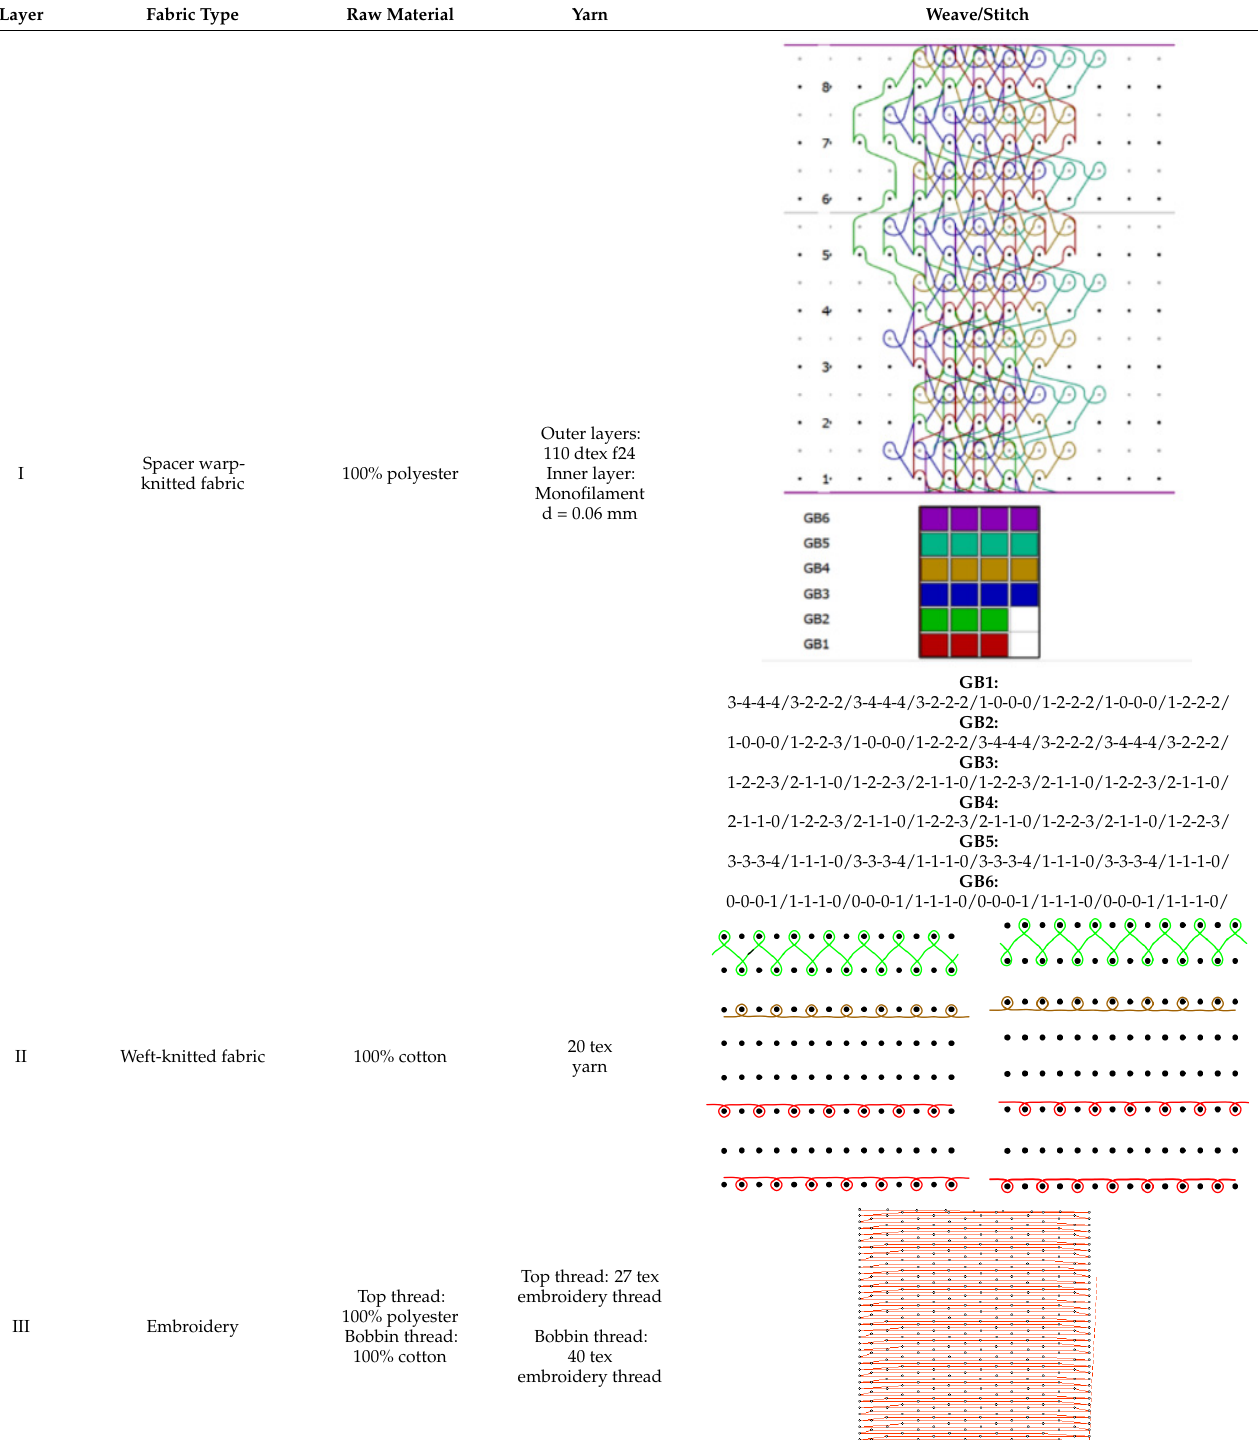
Table 1. The fabrics and raw materials used in the production of footwear. Yarn Weave/Stitch